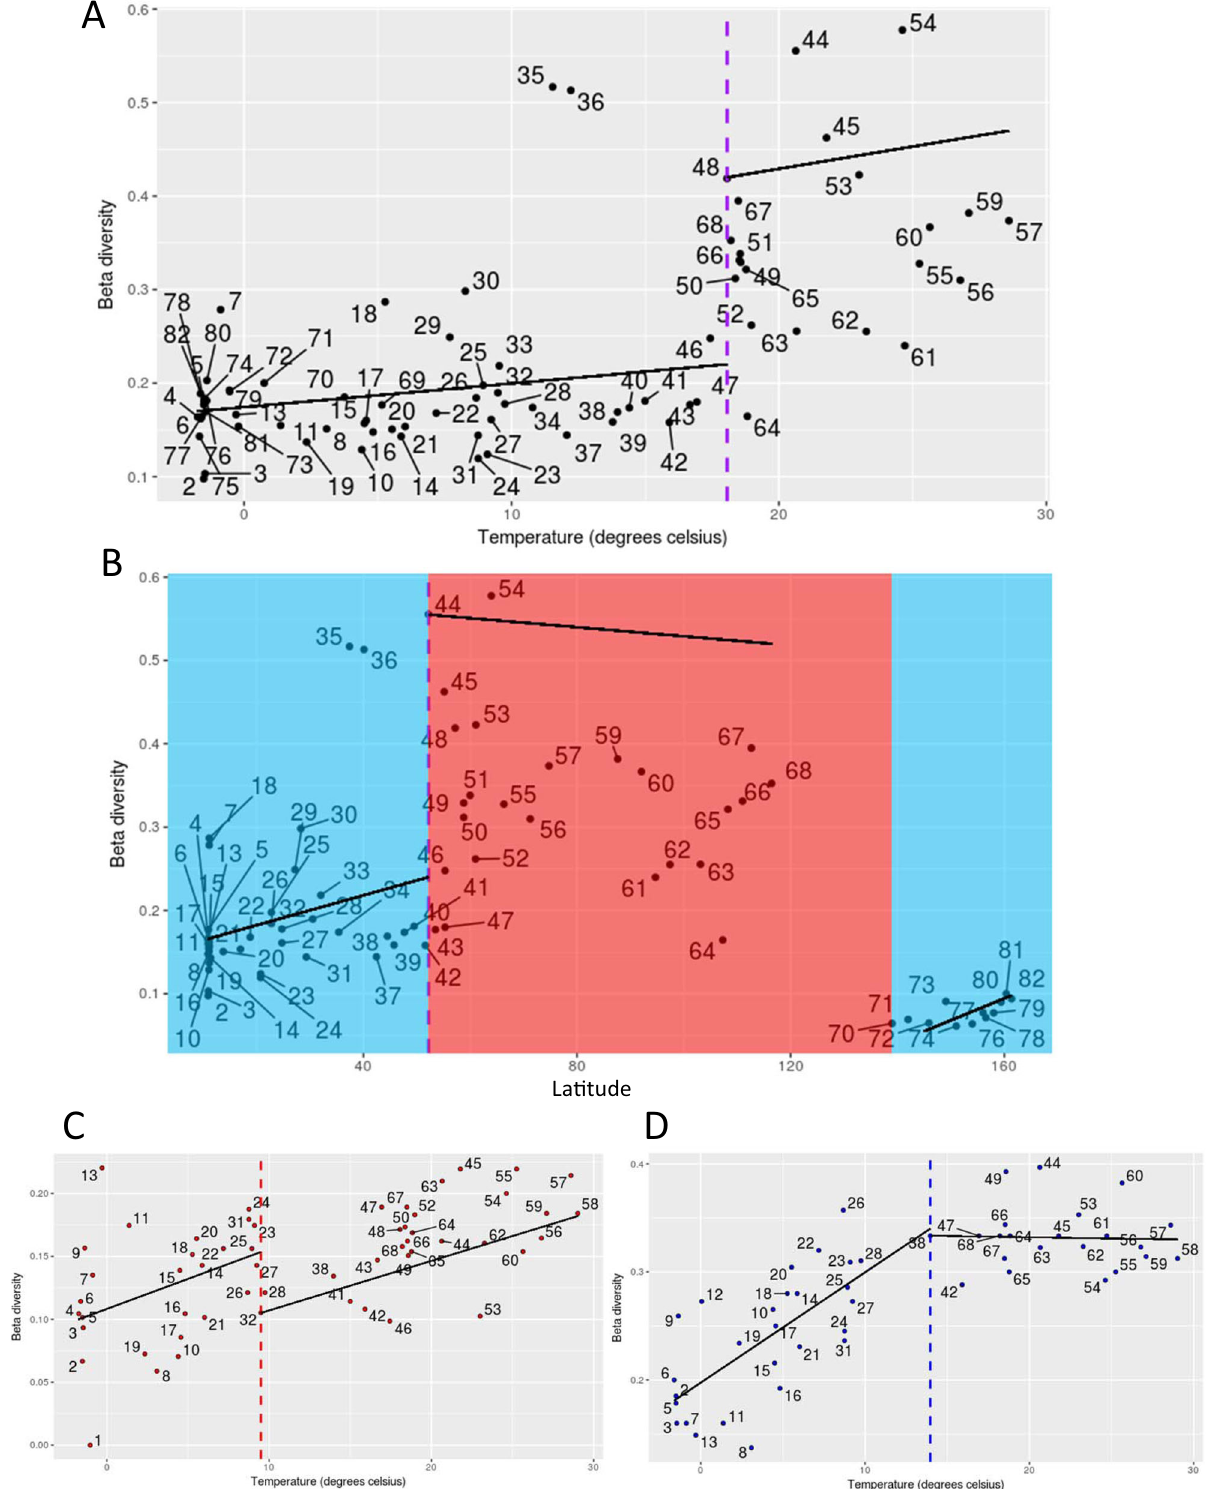
Fig. 5 Beta diversity break-point analyses. A, B Represent breakpoints of protein families as part of the metatranscriptome dataset. C , D Represent breakpoints of the 18S rDNA and 16S rDNA datasets. The numbers correspond to sample locations as shown in Fig. 1A. The y -axis represents beta diversity across all stations. The x -axis in A , C and D represents temperature and in B represents latitude. The horizontal lines indicate the breakpoints in beta diversity. For the Pfam protein families dataset in ( A ), the breakpoint is at 18.06 °C with a p -value of 3.741e − 10. In B the breakpoint is at 52.167 degrees altered latitude (37.833 degrees latitude) with a p -value of 2.225e − 07. For the 16S rDNA dataset in ( C ), the breakpoint is at 9.49°C with a p -value of 1.413e − 4. For the 18S rDNA dataset in ( D ), the breakpoint is at 13.96 °C with a p -value of 8.407e −